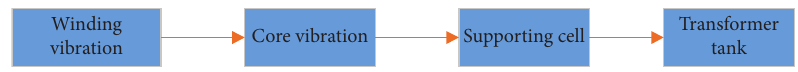
Figure 5: Vibration propagation path of the elevator control transformer.